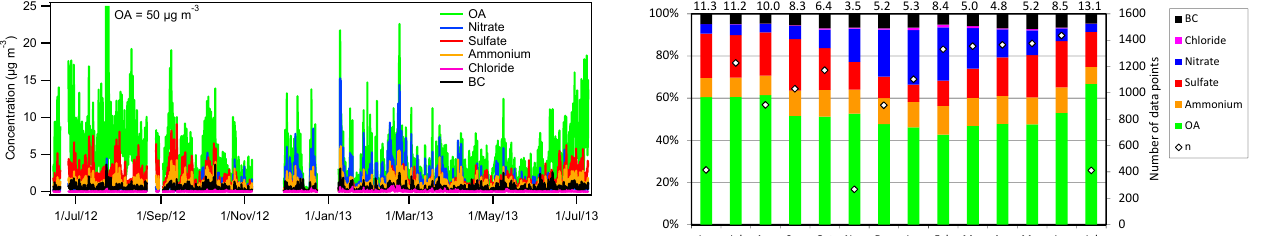
Figure 3. Time series of ACSM components and BC concentrations during the whole study period. Figure 4. Monthly relative chemical composition of submicron